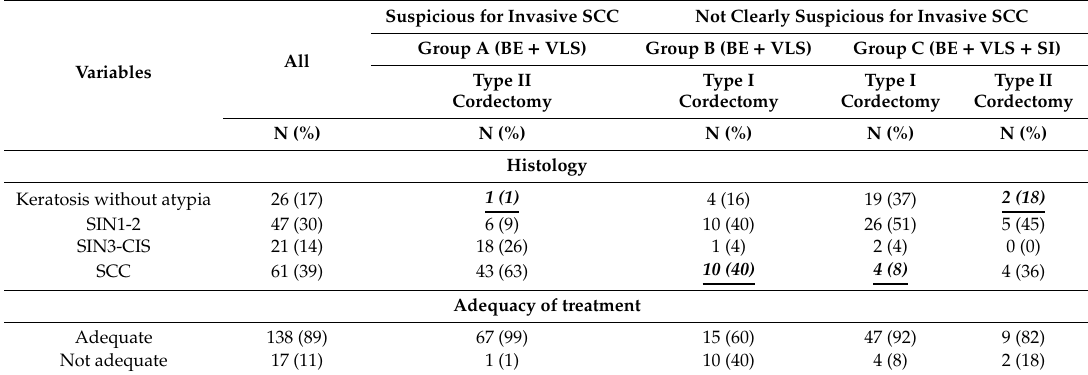
Table 2. Histopathologic diagnosis and adequacy of treatment among